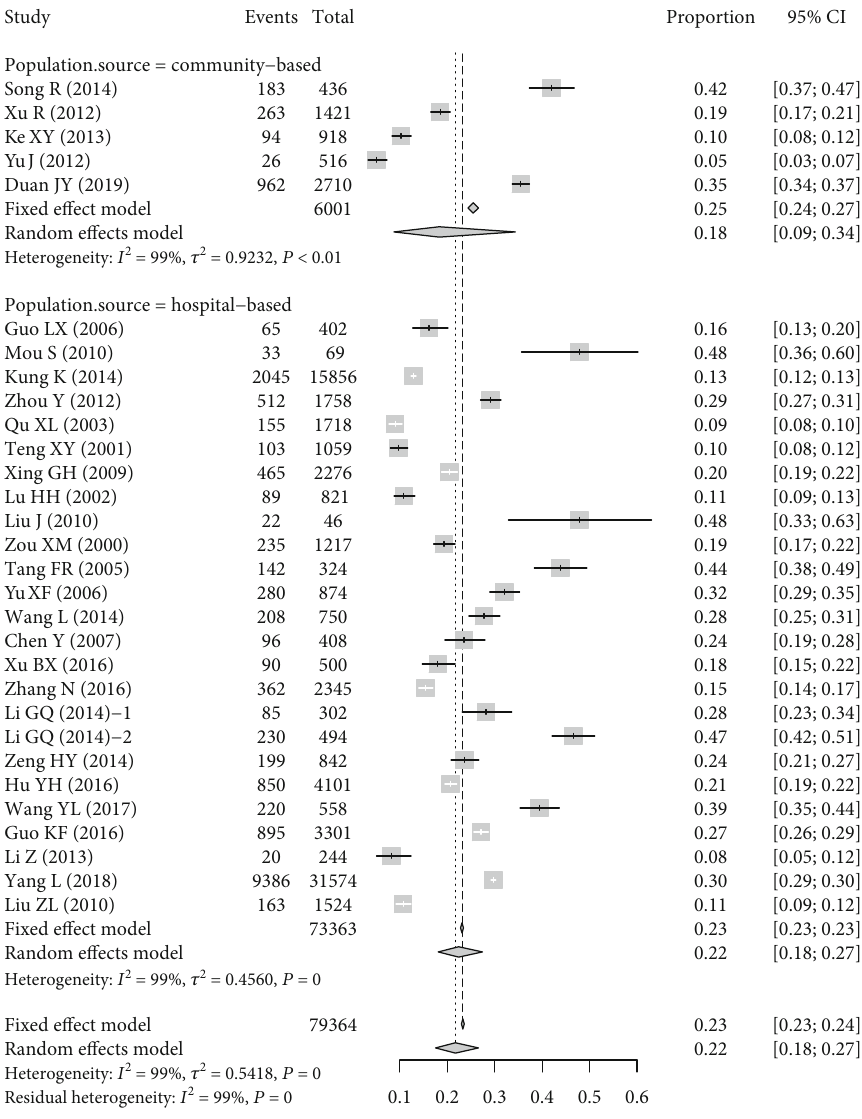
Figure 2: Forest plot displaying the pooled prevalence of DN in patients with type 2 diabetes in both population of DN [47]. This fi nding inspired us that the harm and ben- e fi t of di ff erent biomarkers and de fi nitions for DM and DN on identi fi cation of cases, population prevalence estimation,